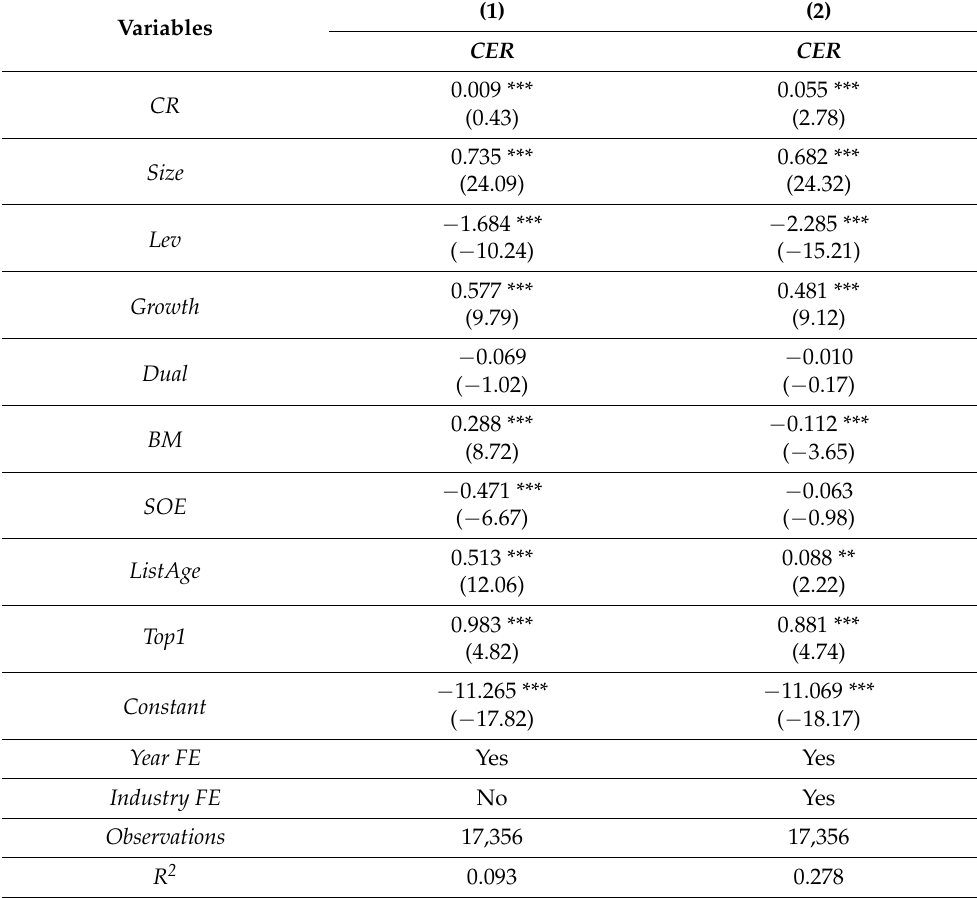
Table 3. Regression of supply chain power on environmental